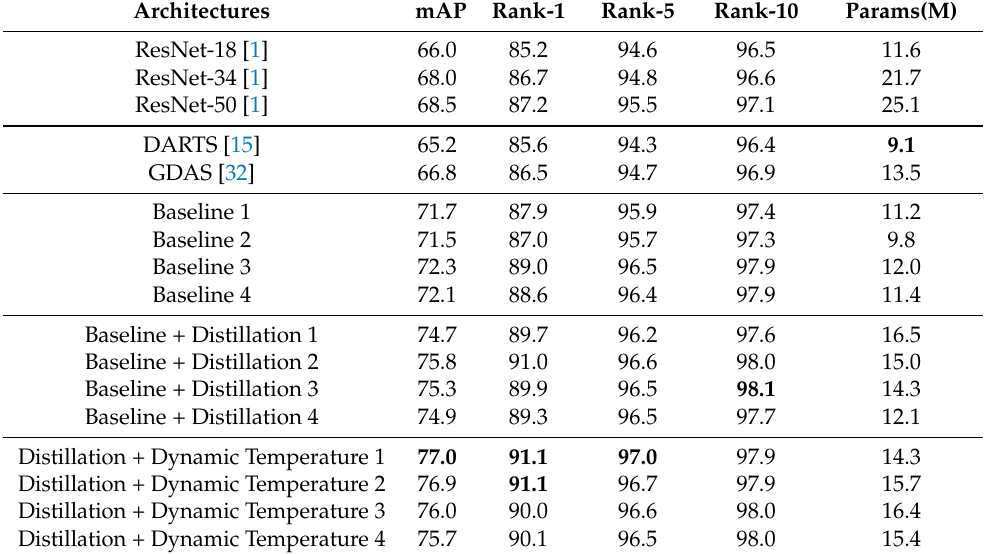
Table 1. We investigated the effect of each component of the KDAS-ReID. All candidates are trained in the same strategy. In addition, no candidates used pre-training on ImageNet except the teacher model. We use the official ResNet-50 network which pre-trains on the ImageNet as the backbone of the teacher model. We have boldfaced the best results in the table.